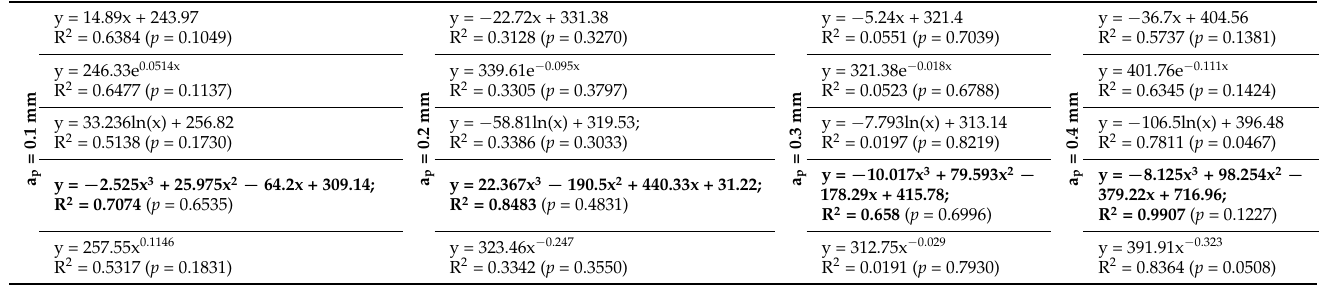
Table 8. Results of mathematical modelling of the T parameter as a function of the feed rate for different values of the depth of cut (regression functions y = T(f z ); f z = x with the coefficient of determination R 2 ).